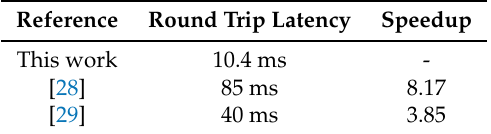
Table 3. Round trip latency and speedup measurement